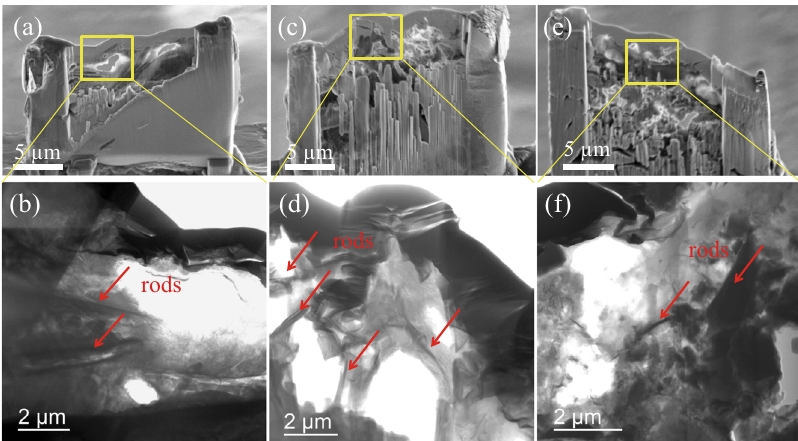
Fig. 9 BF-TEM and BF-STEM images of thin fi lms fabricated from the zircon surface immersed in NaOH (aq). a , c , e Low-magni fi cation BF- TEM images of 150 nm thin fi lms fabricated from the zircon immersed in NaOH (aq). b , d , f High-magni fi cation BF-STEM images obtained from square surrounded area in low-magni fi cation images, respectively. The scale bar on the upper three images is 5 μ m, the bottom is 2 μ